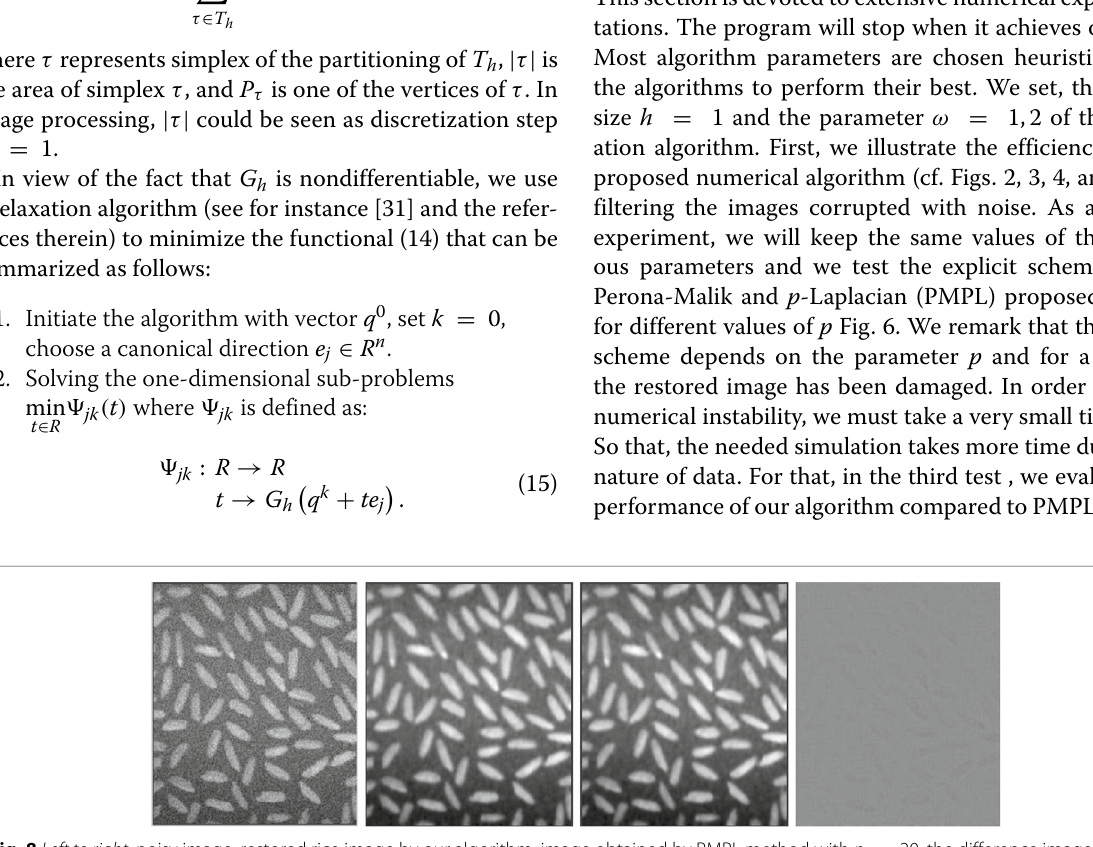
Fig. 8 Lefttoright: noisy image, restored rice image by our algorithm, image obtained by PMPL method with p = 20, the difference